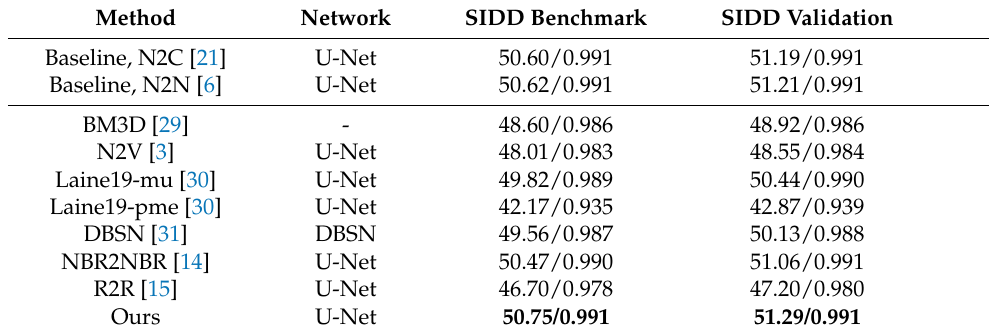
Table 2. Quantitative denoising results on SIDD benchmark and validation datasets in raw- RGB space.